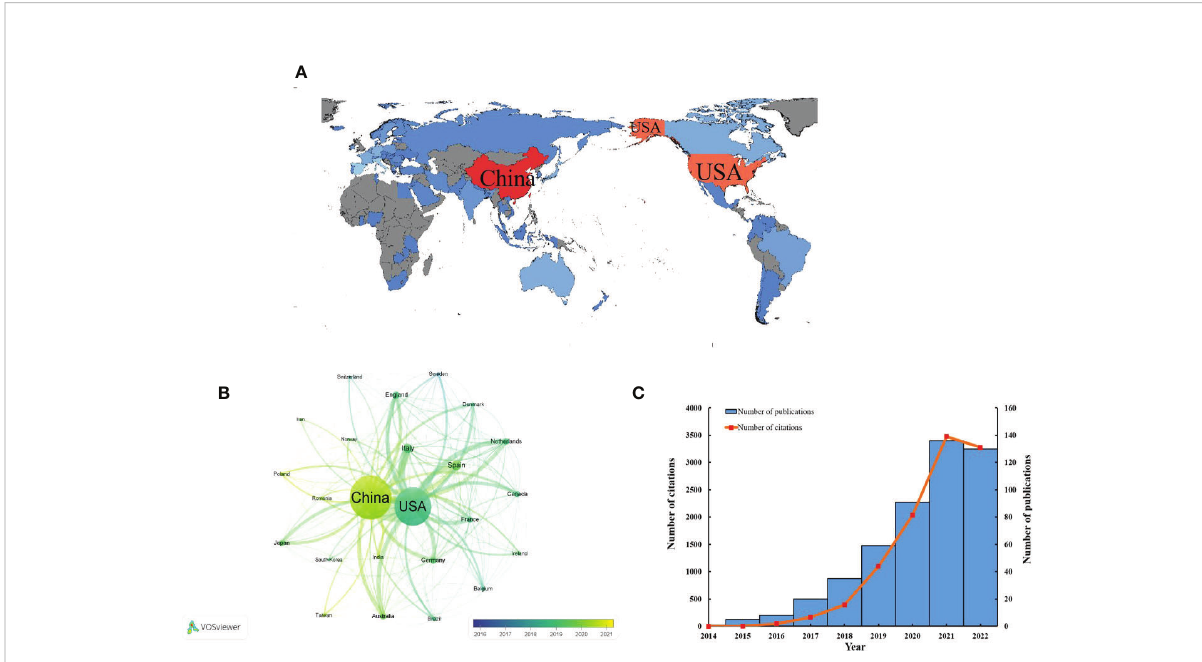
FIGURE 3 (A) Geographical distribution map of global publications related to the GM in CVD. (B) Bibliographic analysis of countries with more than 15 records over time (2016 – 2021). (C) The number of annual publications and citations of articles concerning the GM in CVD from China.